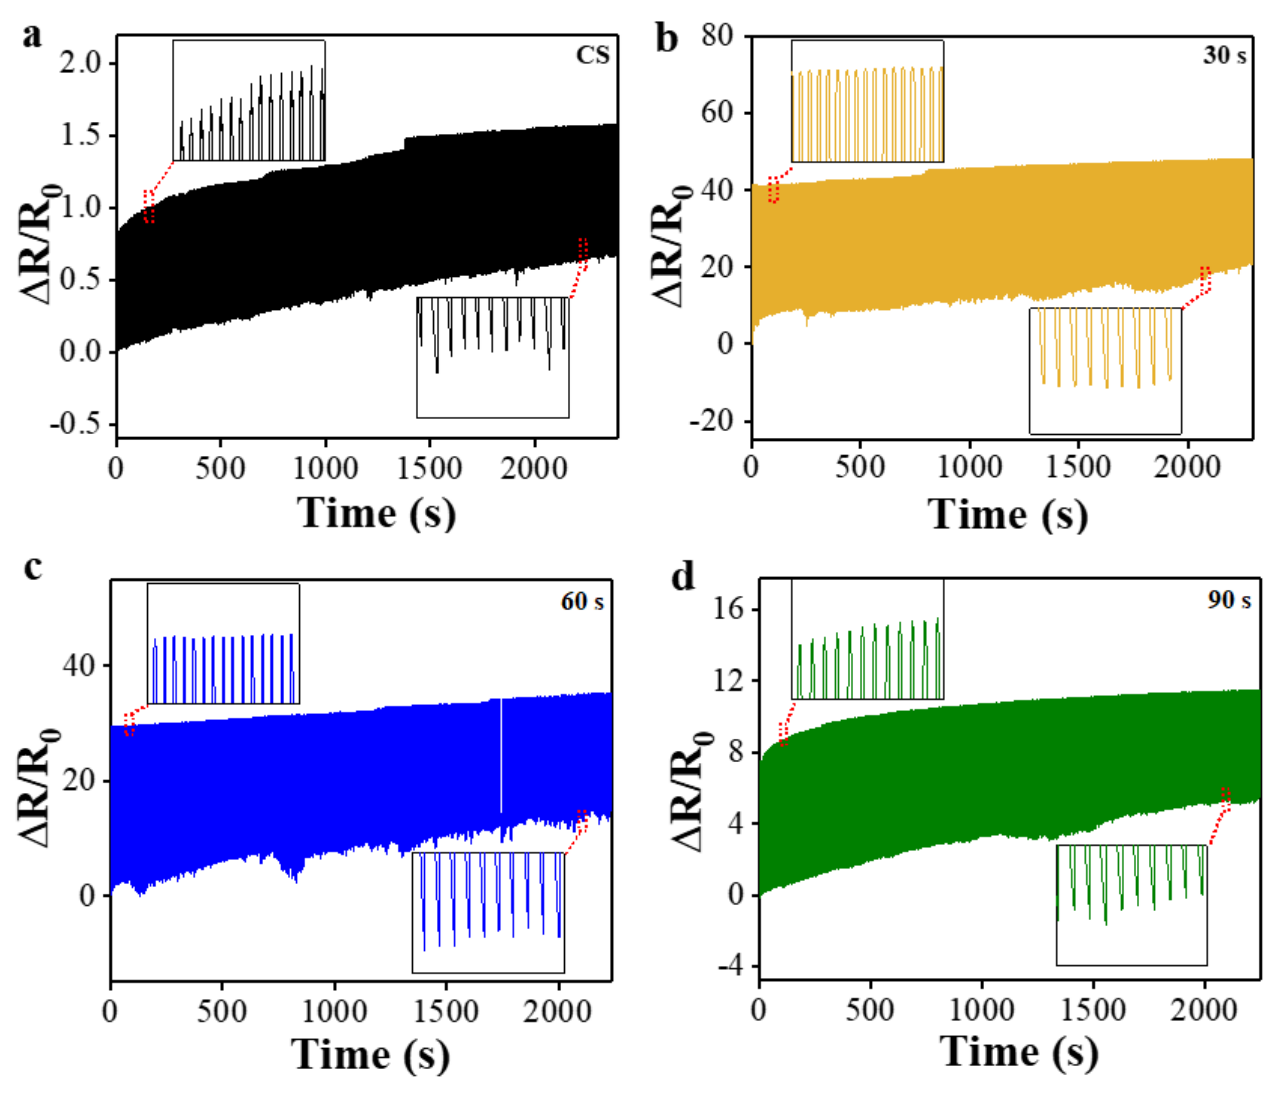
Figure 8. Durability test of the normalized resistance for multilayered PPy/PDMS strain sensors fabricated with various PT time intervals of ( a ) 0 (CS) and, ( b ) 30, ( c ) 60, ( d ) 90 s when subjected to 500 cyclic strains from 0 to 20%.